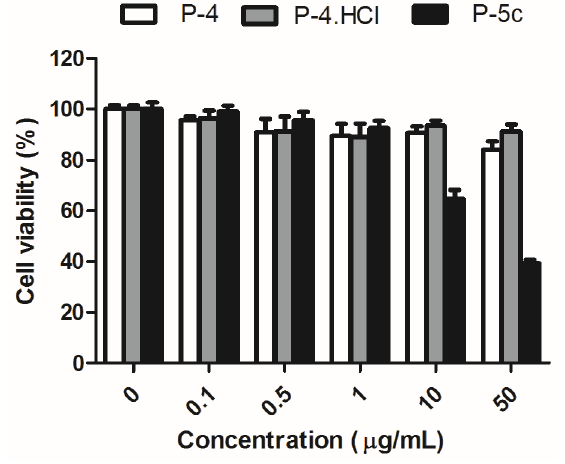
Figure 3. Viabilities of A549 cells at 24 h post-treatment of selected APDs. The P-4, P-4.HCl and P-5c represented the Compound 4 , 4.HCl and 5c shown in Figure 1.